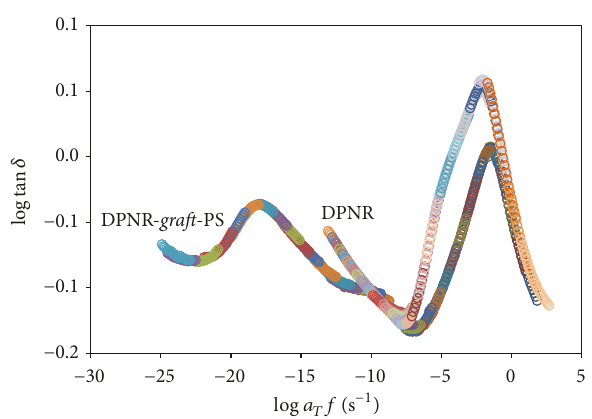
Figure 6: Master curves of tan 𝛿 of DPNR and DPNR- graft -PS.